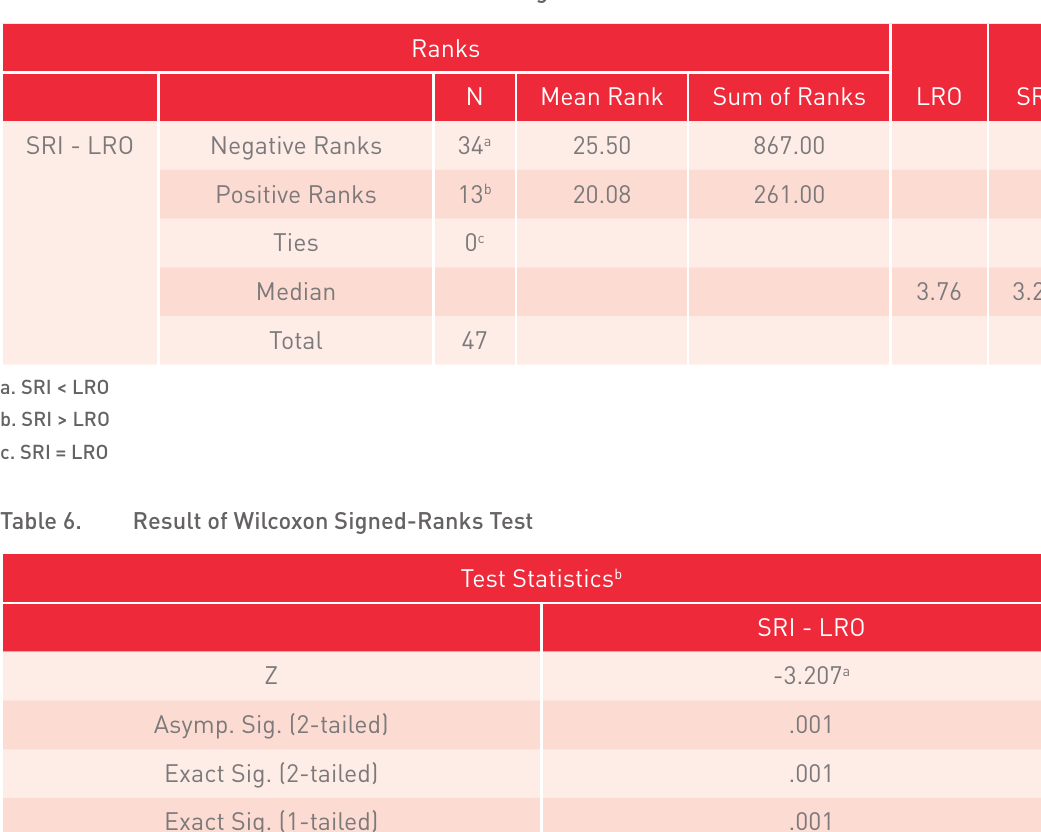
Result of Mean Rank from Wilcoxon Signed-Ranks Test